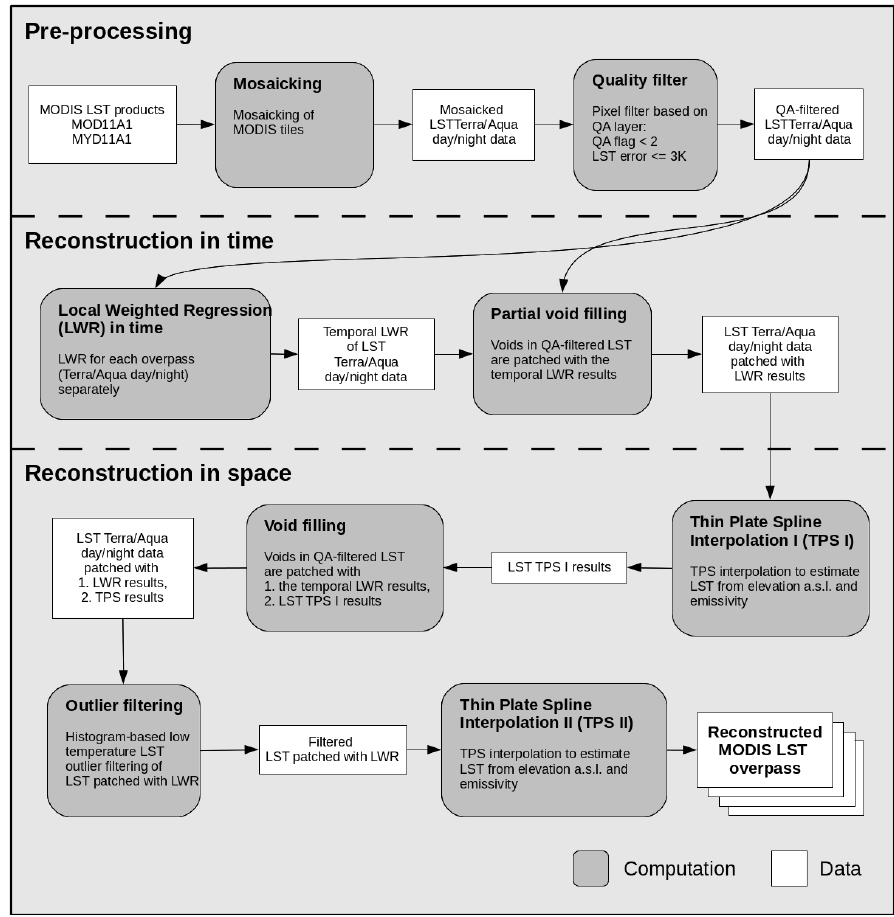
Figure 1. Schematic workflow of the MODIS LST